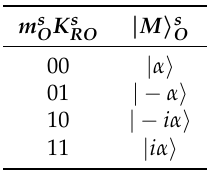
K s and | M (cid:105) s . O RO O